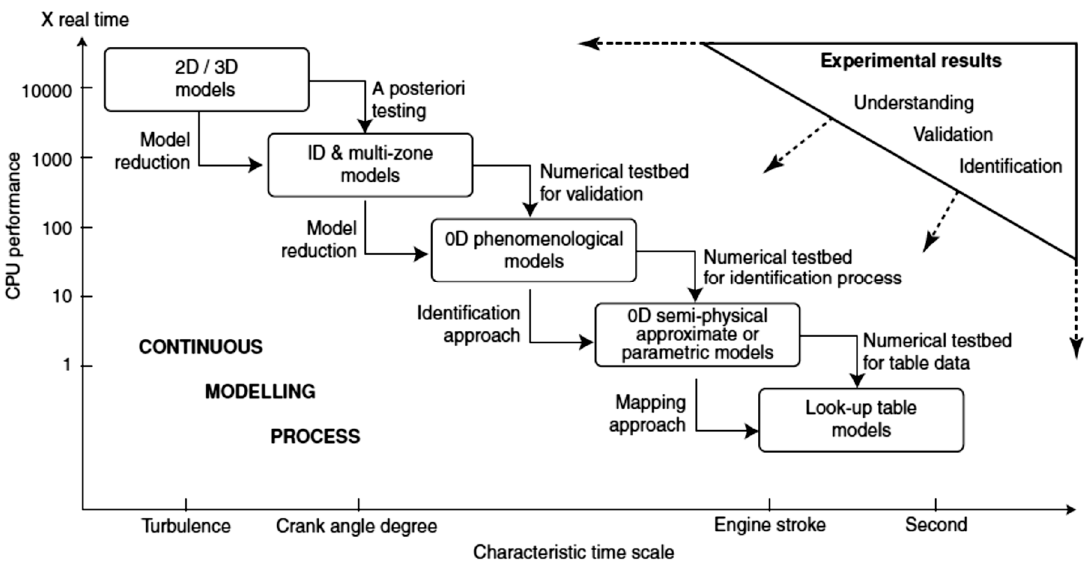
Figure 1. Continuous modelling process reproduced from [13], with permission from EDP Sciences, 2020.